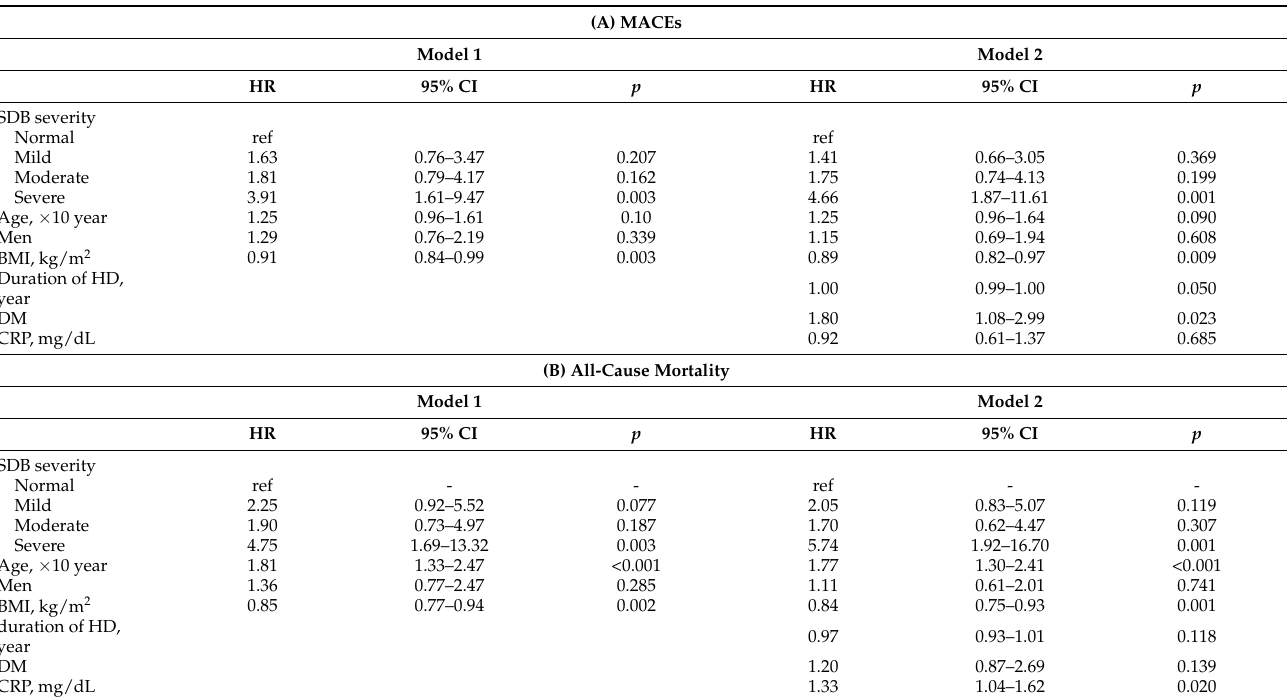
Table 2. Multivariable Cox regression analysis for (A) MACEs and (B) all-cause mortality according to SDB